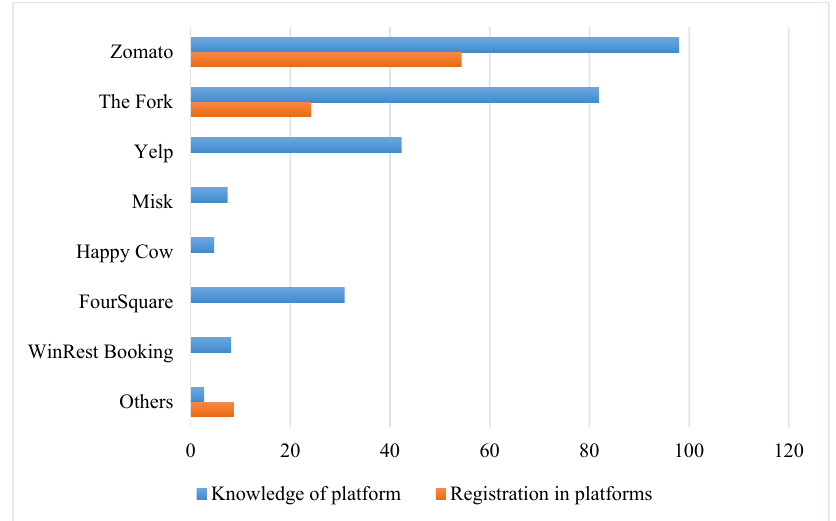
Figure 6. Platforms that managers know and platforms in which the firm is registered (%). This data encompasses firms registered by users in TripAdvisor.